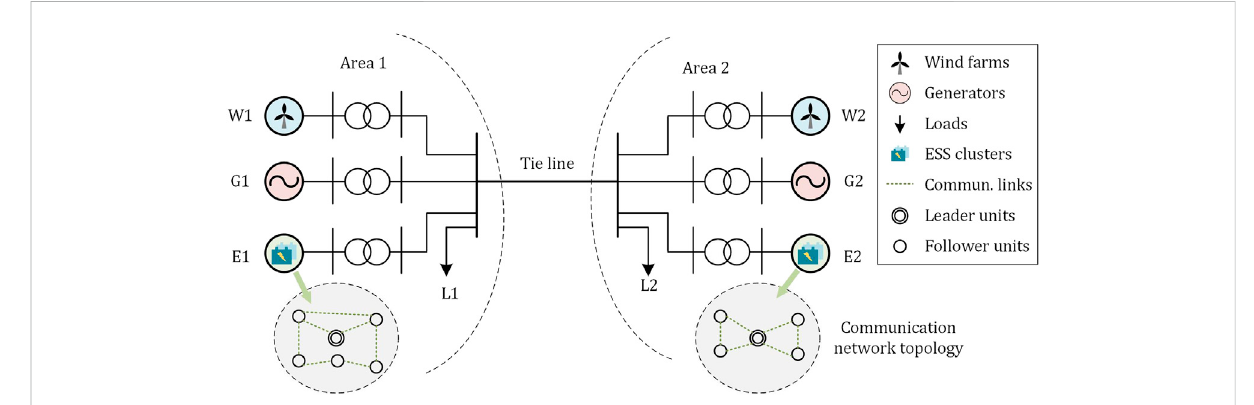
FIGURE 4 Structure of two-area systems considering wind power and energy storage systems.